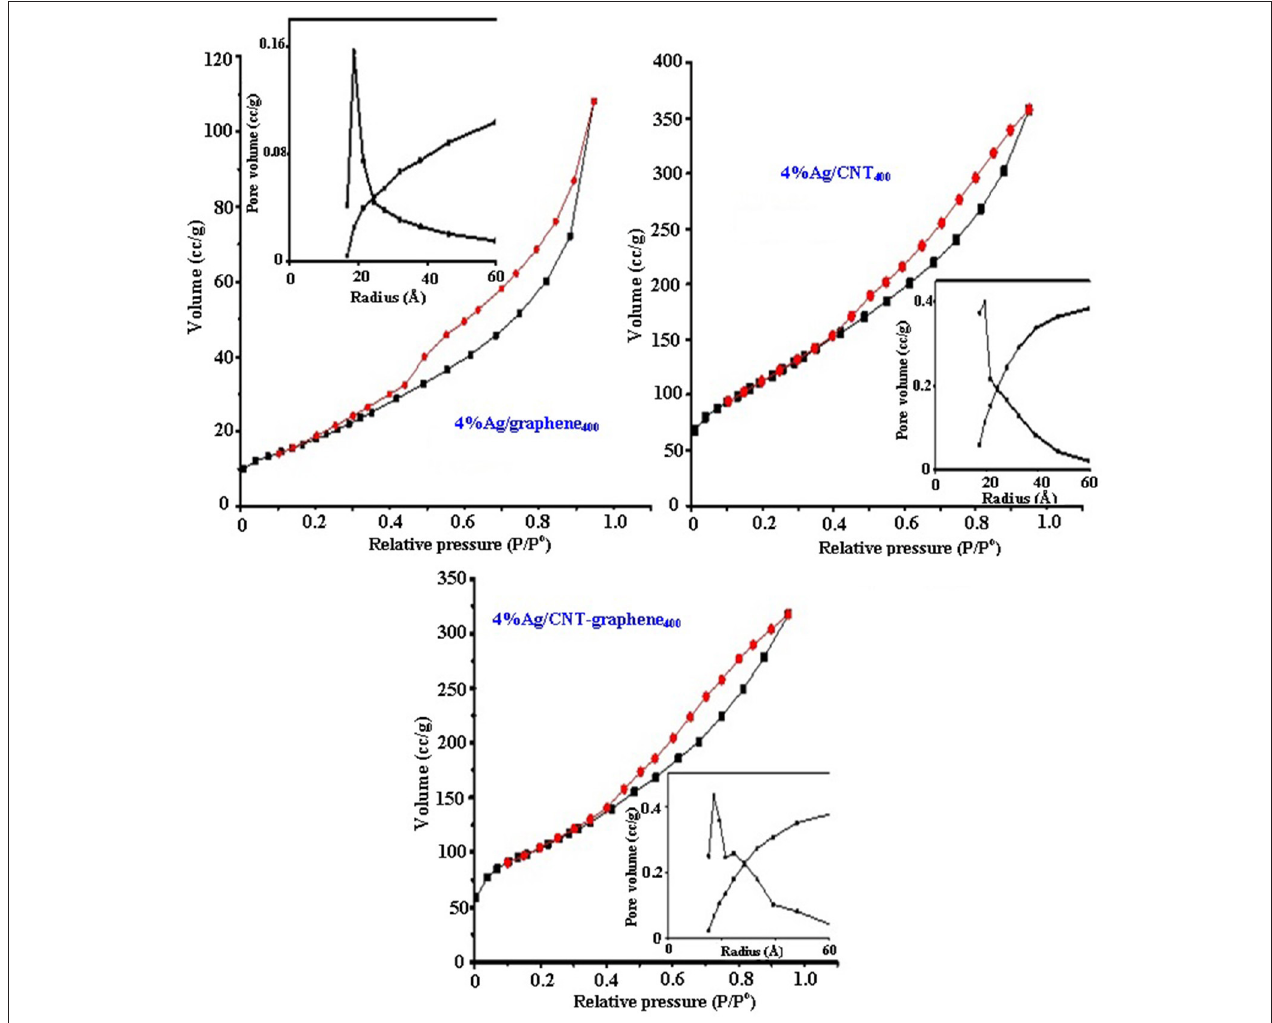
FIGURE 3 | Adsorption-desorption isotherms and pore size distribution curves (in-set) of 4%Ag/CNT 400 , 4%Ag/graphene 400 , and 4%Ag/CNT-graphene 400 .